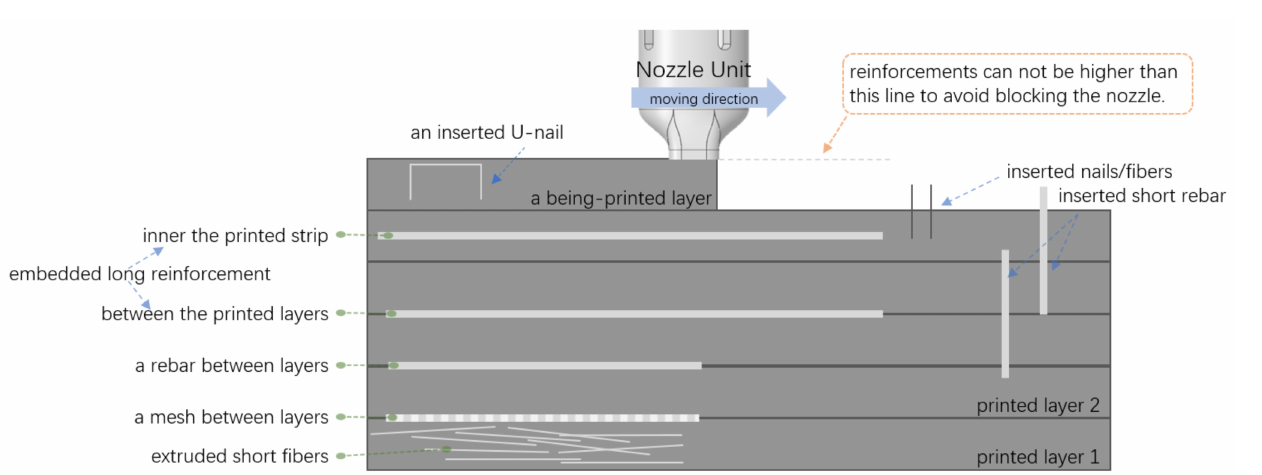
Figure 11. Locations of the reinforcements in the cement structure: inner the strips, across the interfaces, and outer the